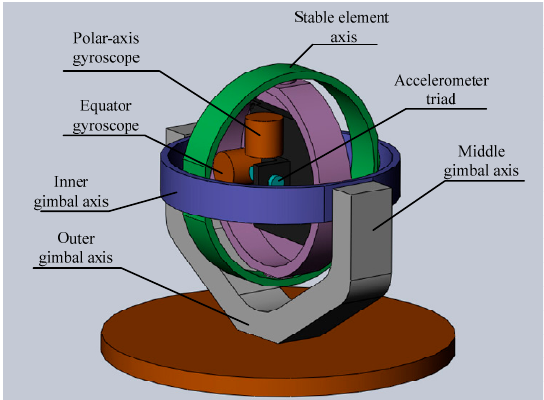
Figure 1. Structure of the space-stable platform.